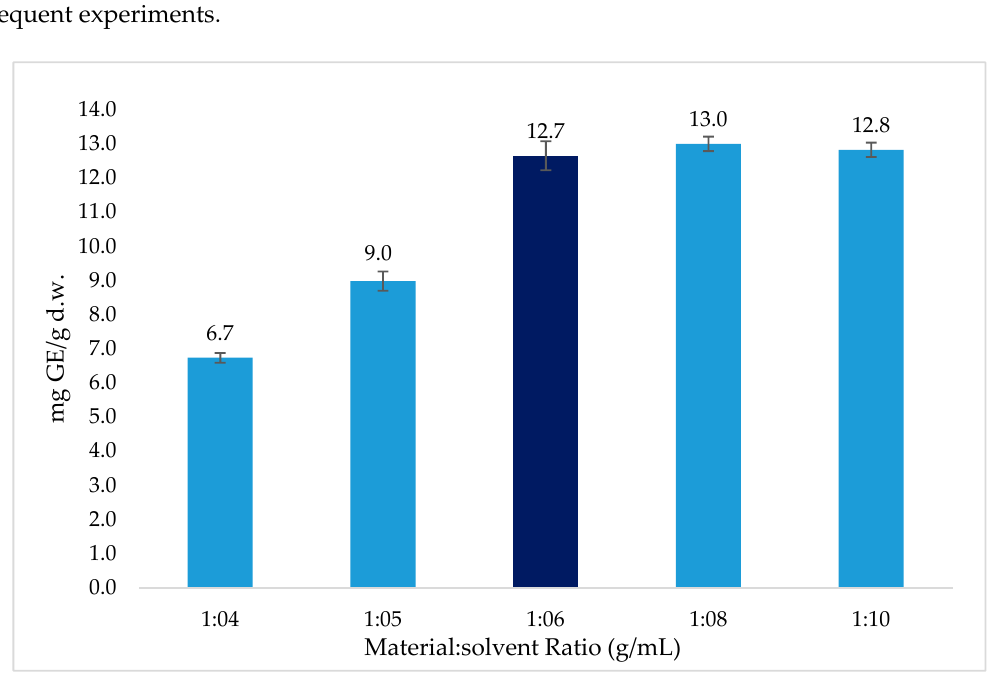
Figure 4. Effect of material:solvent ratio.